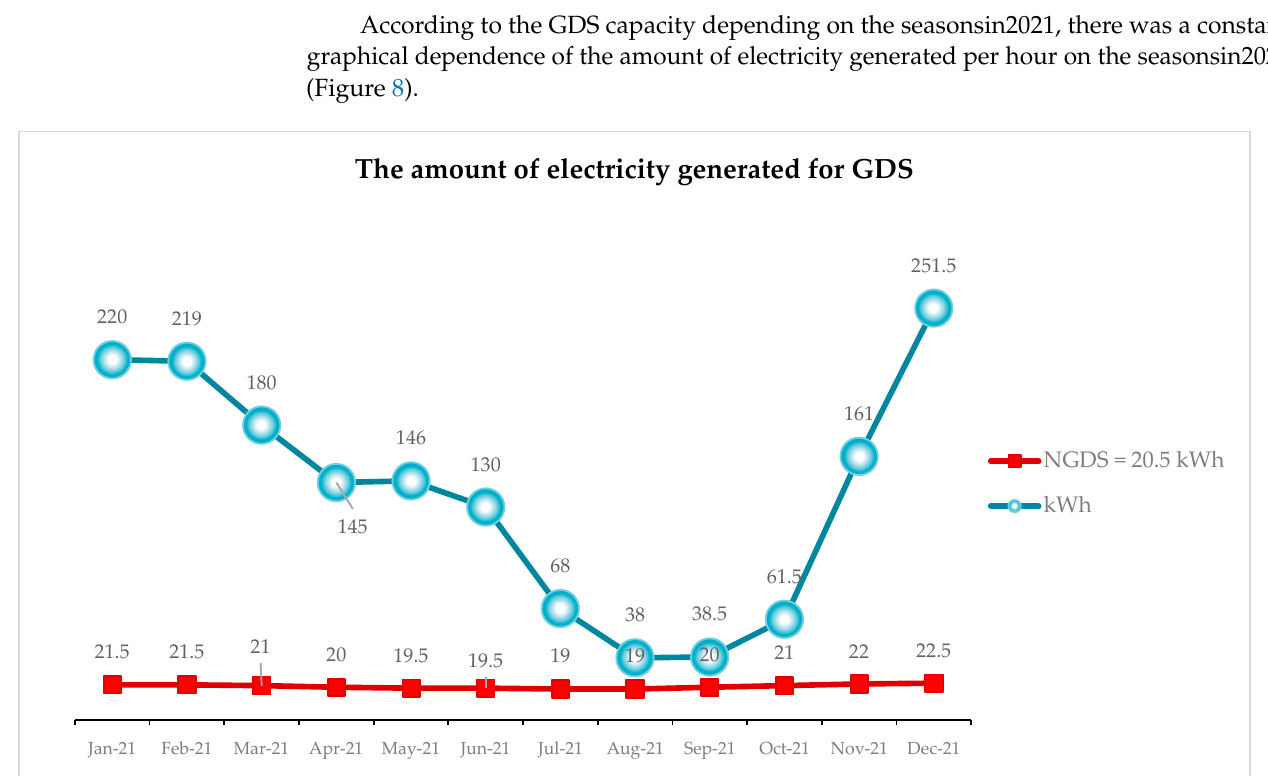
Figure 8. The amount of electricity generated for GDS.